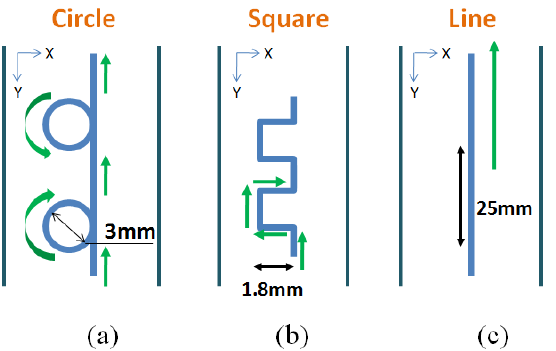
Figure 2. Cutting path designs in micro milling: ( a ) circle path cutting; ( b ) square path cutting; ( c ) straight line cutting.